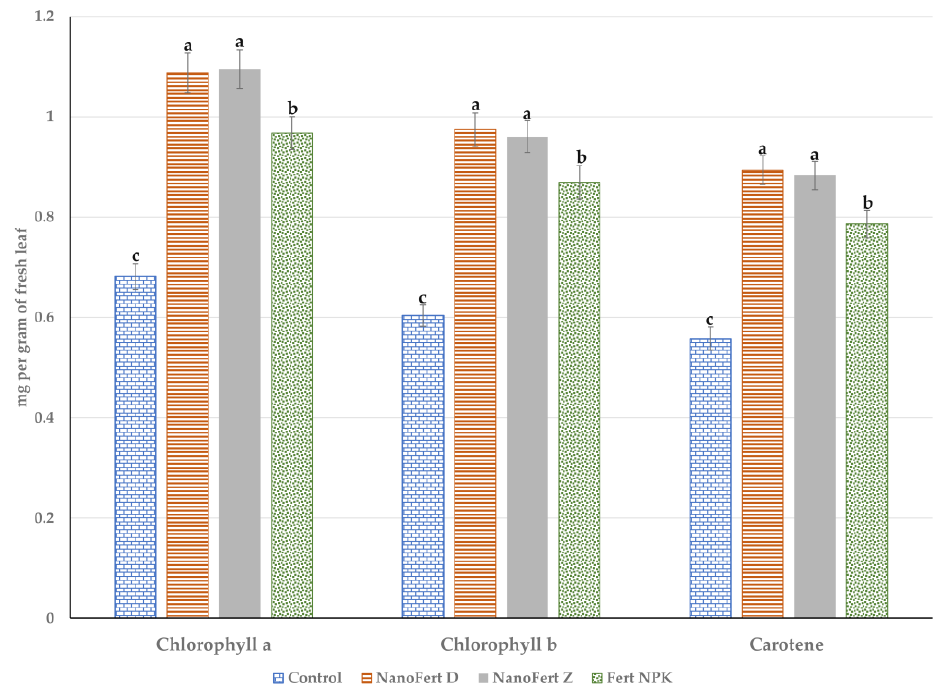
Figure 2. The effects of the experimental treatment with foliar fertilizers and foliar fertilizers with particle film-forming SNNMs on the photosynthetic pigments of the leaves from the apple trees. Orchard of “Vasili Adamachi” experimental farm, Faculty of Horticulture, “Ion Ionescu de la Brad” Iasi University of Life Sciences, 2021. Values followed by the same letter do not differ significantly at p < 0.05.